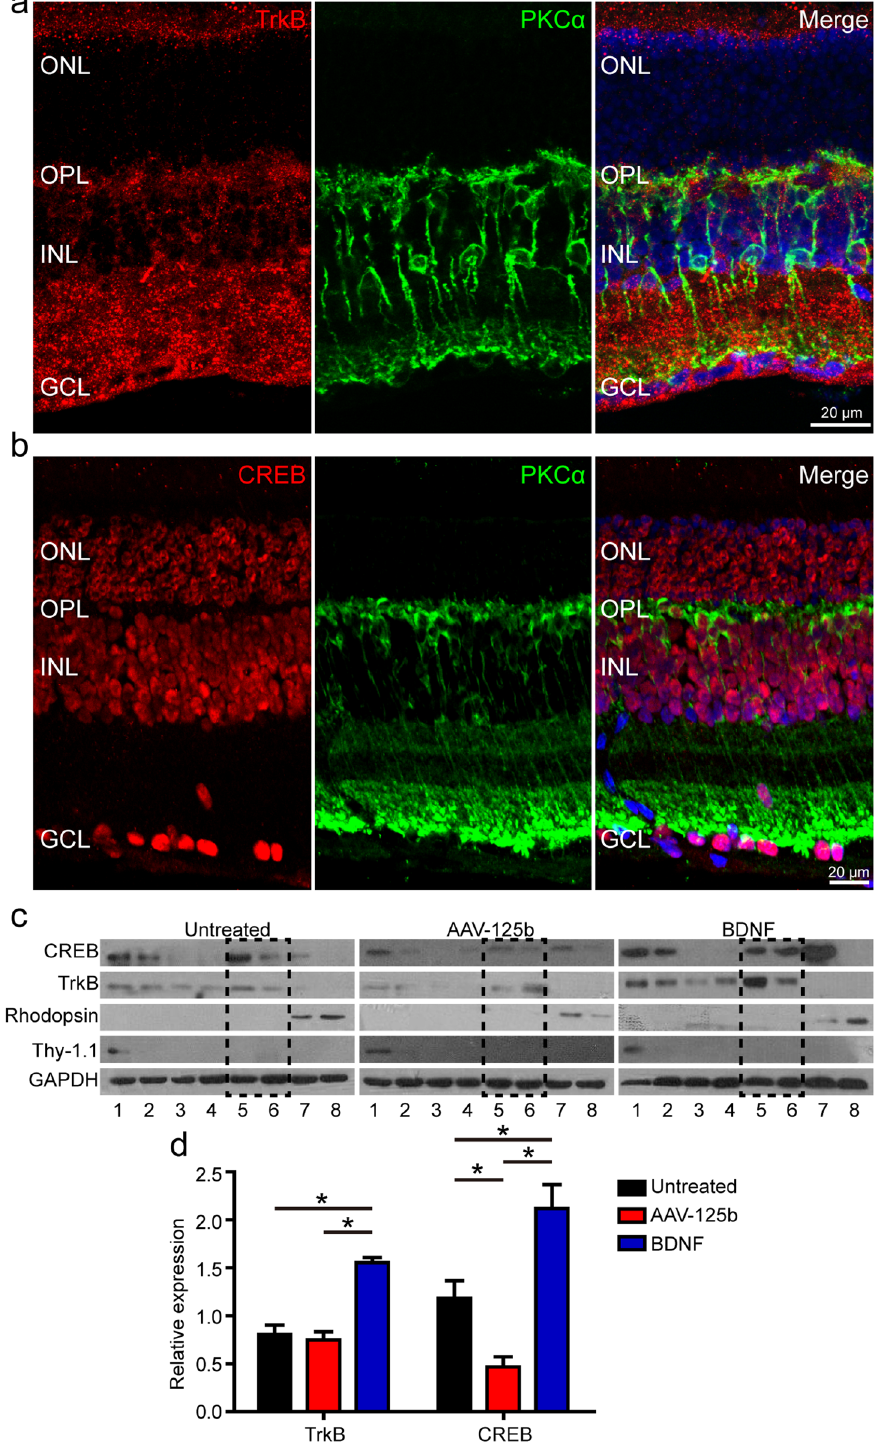
Figure 7. Regulation of RBC ectopic dendrites by the BDNF-TrkB-CREB pathway in RCS rats. ( a ) Immunostaining for TrkB and PKC α in the retinae of P36 RCS rats. ( b ) Immunostaining for CREB and PKC α in the retinae of P36 RCS rats. ( c ) Western blot assay of retinal serial sections in P60 RCS rats, five weeks after AAV-125b or BDNF treatment. The control group consisted of untreated retinae. GAPDH was used as a loading control. The dotted box indicates the position of the OPL and ONL. For original blot images, please see Supplementary Fig. 14. ( d ) The normalized expression of TrkB and CREB in the retinal fractions (bars show means; error-bars, SD; n = 3). ONL: outer nuclear layer; OPL: outer plexiform layer; INL: inner nuclear layer; GCL: ganglion cell layer. * p <